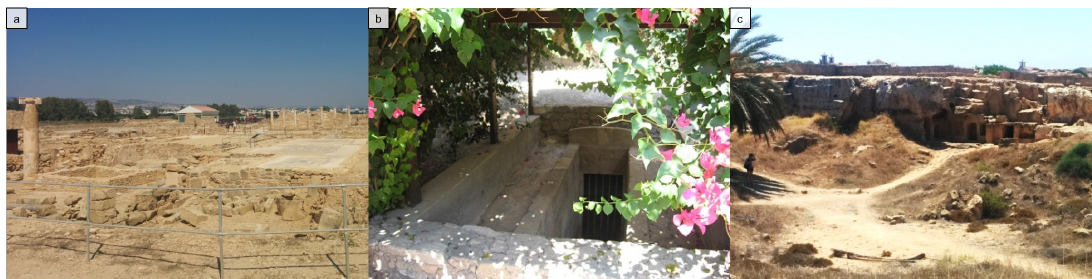
Figure 1. Contextual photographs of archaeological sites analyzed from ancient Nea Paphos: ( a ) The Paphos Archaeological Park; ( b ) The location of Tomb Roma 1, under the present-day Roman Boutique Hotel; ( c ) The Tomb of the